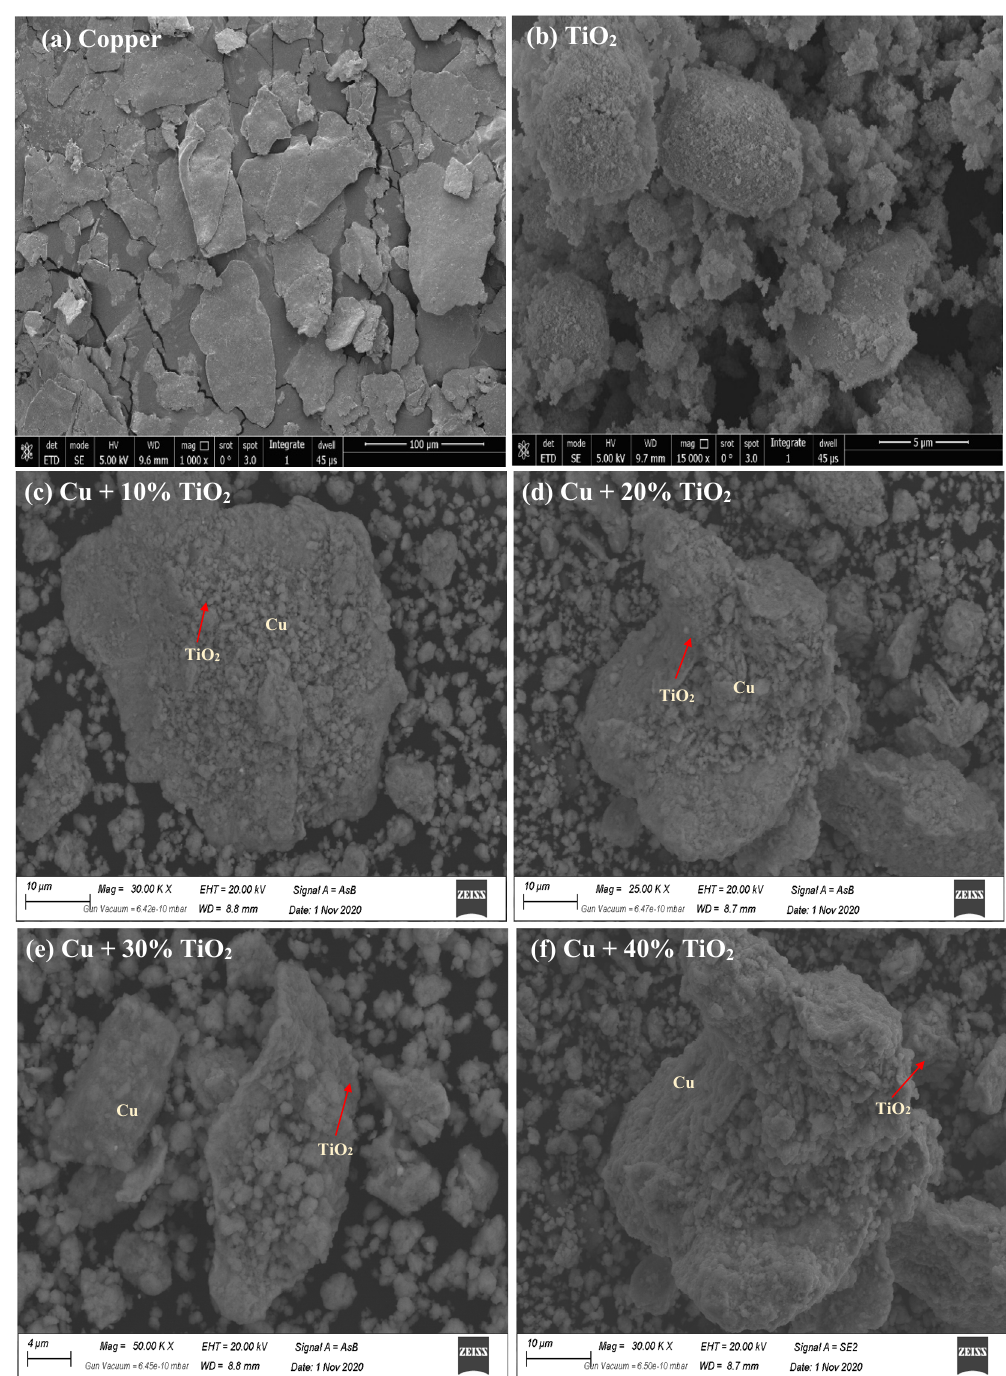
Figure 4. Representative the SEM micrographs of the Cu composite with different concentrations of nano-TiO 2 ( a ) represents Cu only ( b ) represents Cu only at higher magnification ( c ) represents Cu with 10 wt.% TiO 2 ( d ) represents Cu with 20 wt.% TiO 2 ( e ) represents Cu with 30 wt.% TiO 2 ( f ) represents Cu with 40 wt.% TiO 2